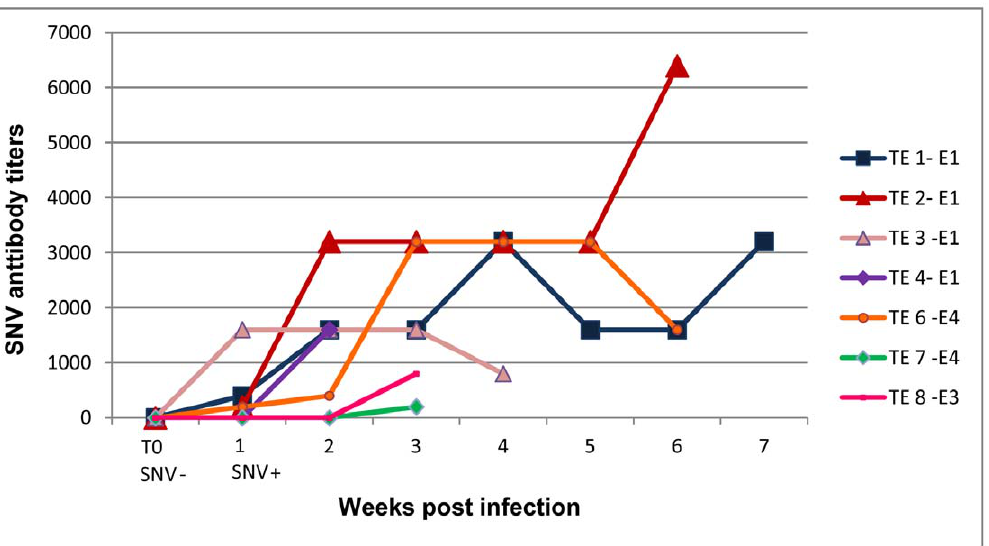
Figure 2. SNV antibody titers in all TE deermice in experiment 4. E1, E4, and E3 are enclosures in which each TE deermouse became infected. T0 represents the last blood sample negative for both SNV RNA and antibody to SNV before antibody or RNA was detected.